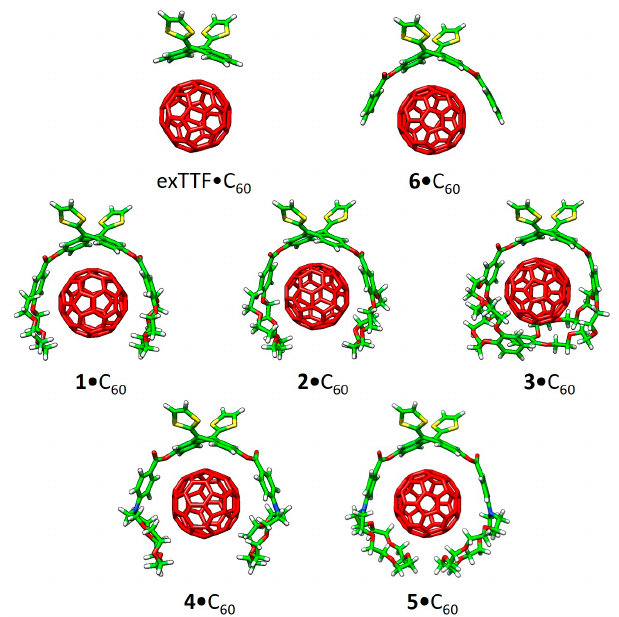
Figure 5. B97-D/cc-pVDZ minimum-energy geometries calculated for the exTTF • C 60 and 1 – 6 • C 60 complexes. The electron-acceptor C 60 is colored in red whereas the sulfur, carbon, oxygen and hydrogen atoms in the electron-donor system are colored in yellow, green, red and white,